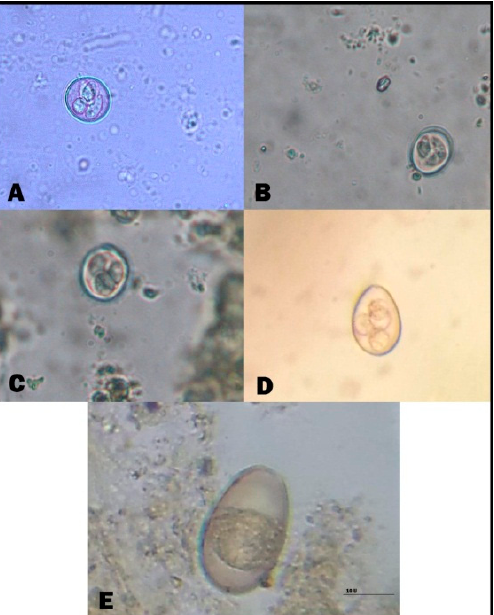
Figure 2. Diarrhea-causing intestinal parasites in cattle and buffalo calves. ( A ) Eimeria zurnii (sporulated oocyst); ( B ) Eimeria ellipsoidalis (sporulated oocyst); ( C ) Eimeria alabamensis (sporulated oocyst); ( D ) Eimeria bovis (sporulated oocyst); ( E ) Eimeria bukidnonensis (unsporulated oocyst). ( Scale bar = 20 μ m).